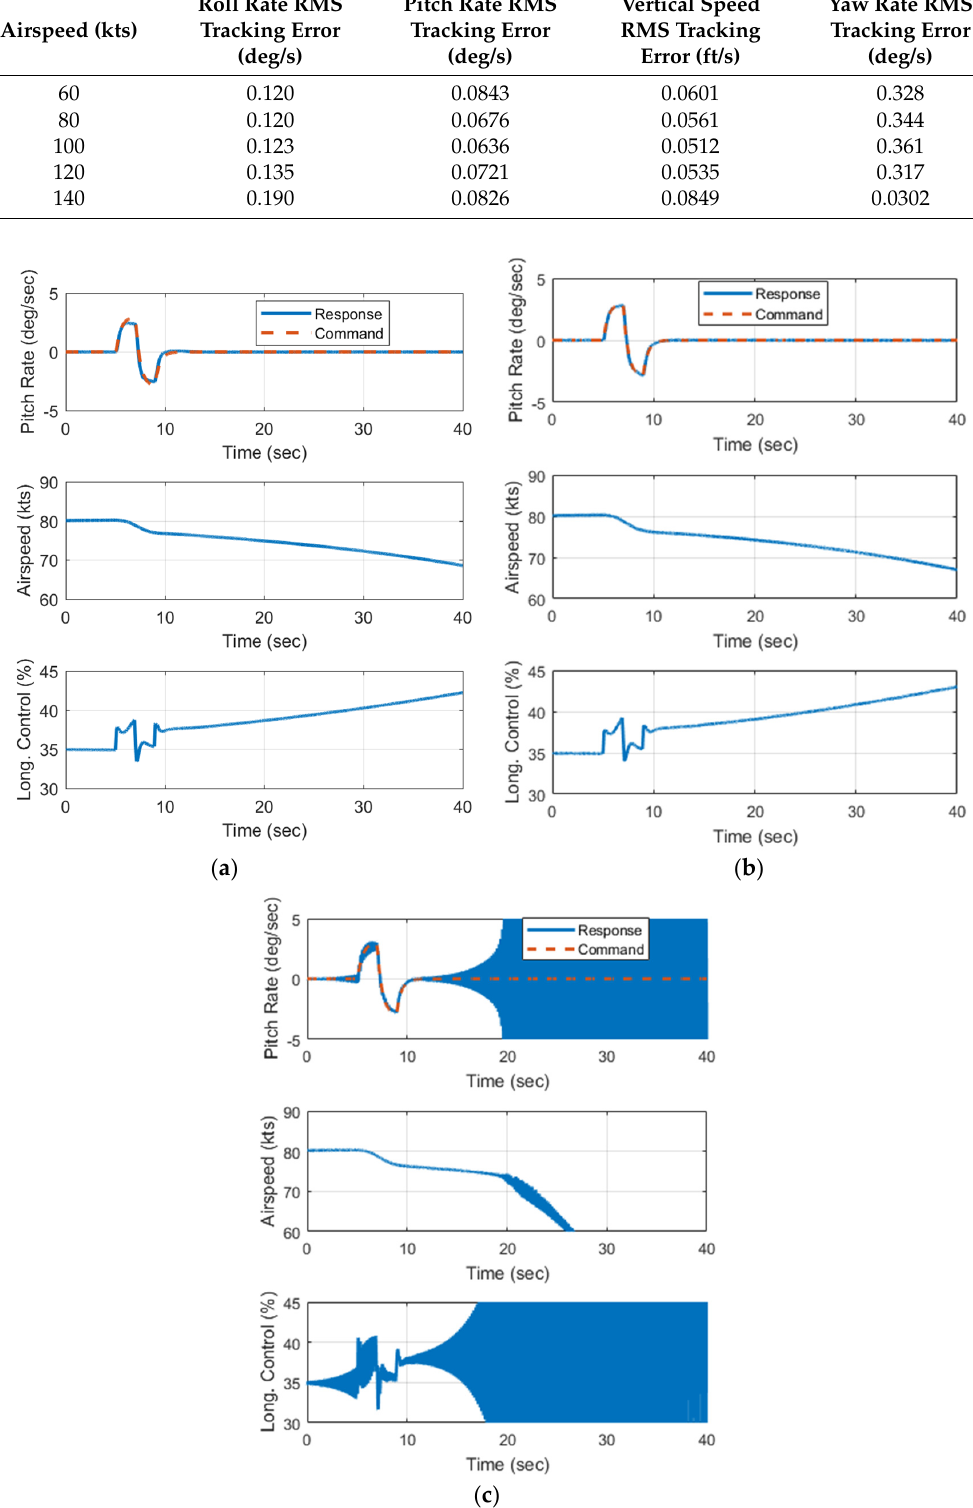
Figure 13. Time history response for a 3 deg/s pitch rate doublet: ( a ) with final controller design; ( b ) without output redefinition in the pitch axis; ( c ) with high pitch axis gains (error dynamic frequency ω n = 6.8 rad/s).